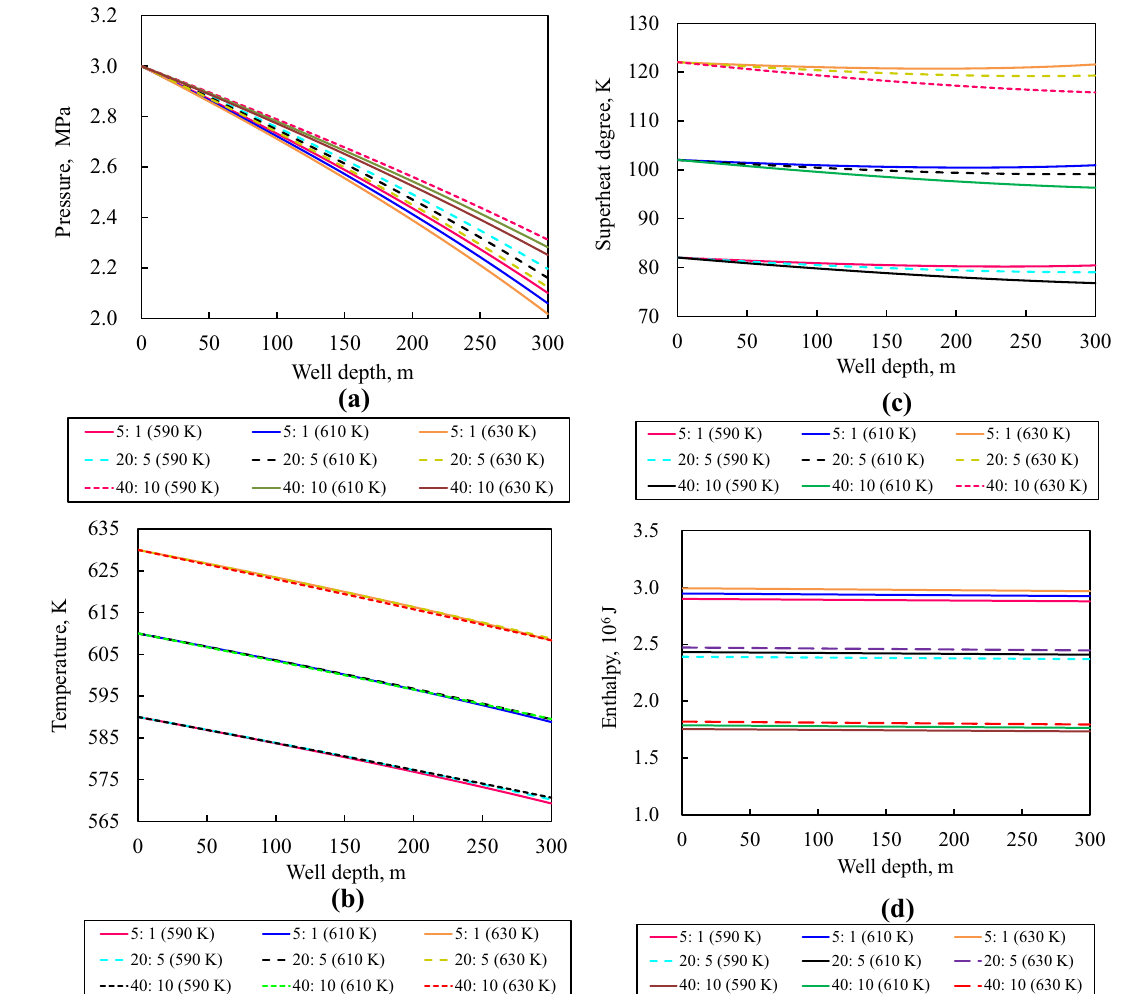
Fig. 2 Effect of injection temperature on the profiles of thermophysical properties of SMTF in wellbores under various mass content of non- condensing